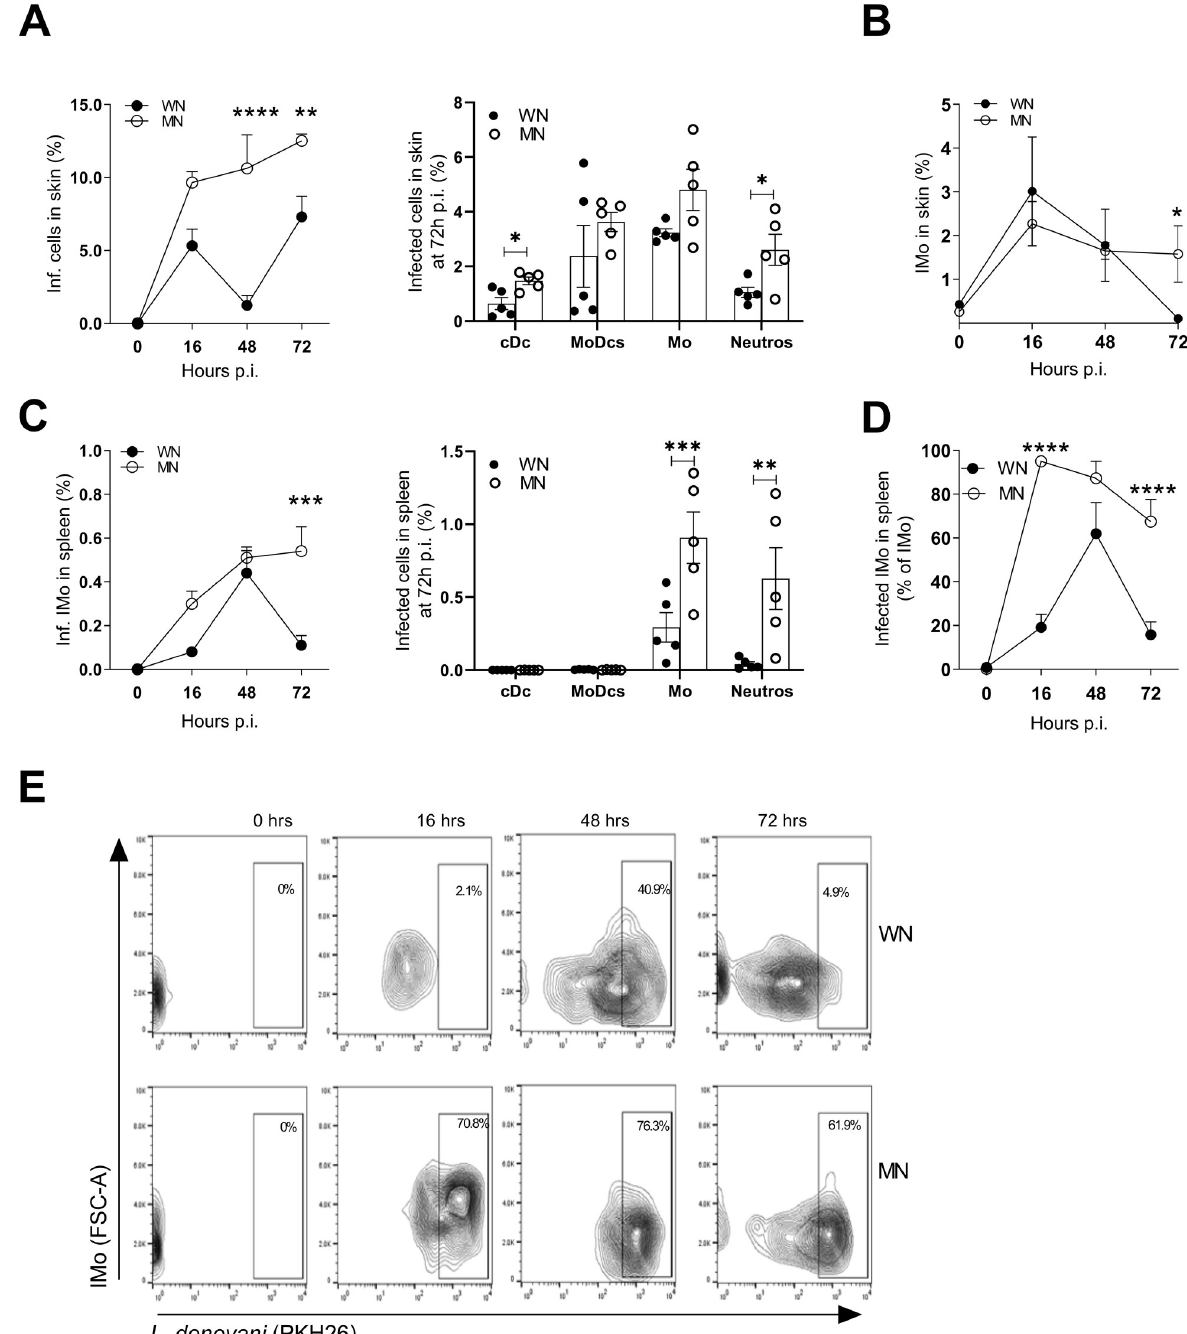
Fig 1. Parasite burden is increased in malnourished mice infected with L . donovani . A . Kinetics of accumulation of infected cells (Left panel) and percent of infected cells including conventional dendritic cells (cDC), monocyte derived dendritic cells (MoDCs), monocytes (Mo), and neutrophils (N) in skin at 72 hr post-infection (Right panel), relative to the total skin cells. �� p < 0.01, ���� p < 0.0001 (2-way Anova, Sidak’s multiple comparison test); � p < 0.05 (Unpaired t-test). B . Kinetics of inflammatory monocyte (Imo) accumulation as percentage of total cells in the skin of WN or MN mice following intradermal L . donovani infection. � p = 0.05 (Unpaired t-test). C. Kinetics of infected inflammatory monocyte (Imo) accumulation showed as percentage of total cells in the spleen of WN and MN mice following intradermal L . donovani infection (Left panel) and percent of infected cells relative to total spleen cells at 72 hr after intradermal infection with L . donovani (Right panel). ��� p = 0.0001 (2-way Anova). ��� p = 0.008; �� p = 0.014 (2-way Anova). D. Percent of infected inflammatory monocytes represented with reference to the parental population (inflammatory monocytes) in the spleen of WN and MN mice following intradermal L . donovani infection. ���� p < 0.0001 (2-way Anova). E